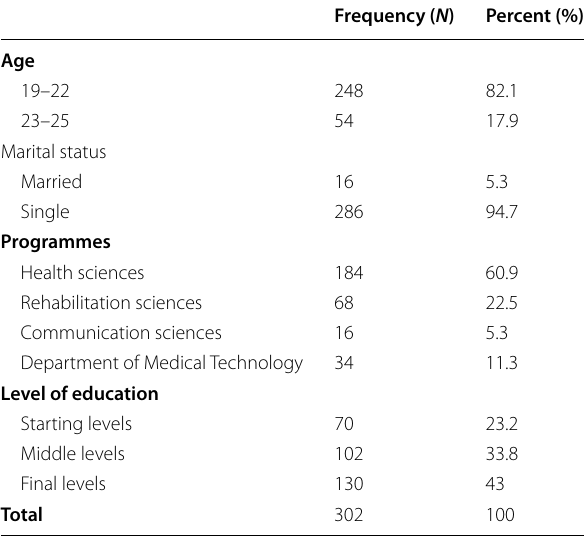
Table 1 Characteristics of study participants